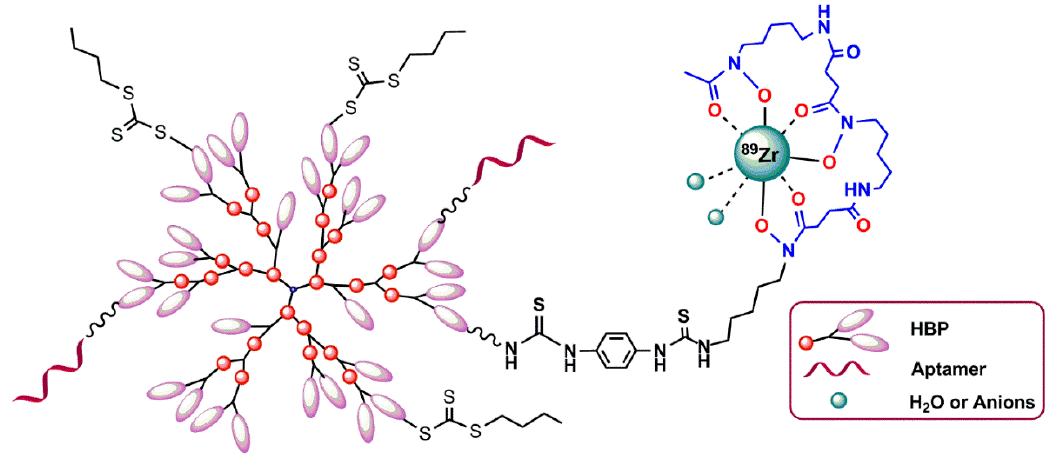
Figure 18. Oligonucleotide aptamer–hyperbranched polymer (HBP) conjugates as a targeted molecular imaging probe.